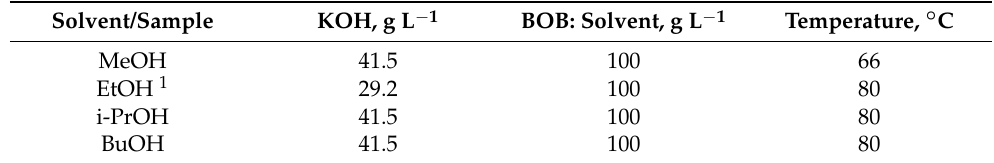
Table 1. Depolymerization